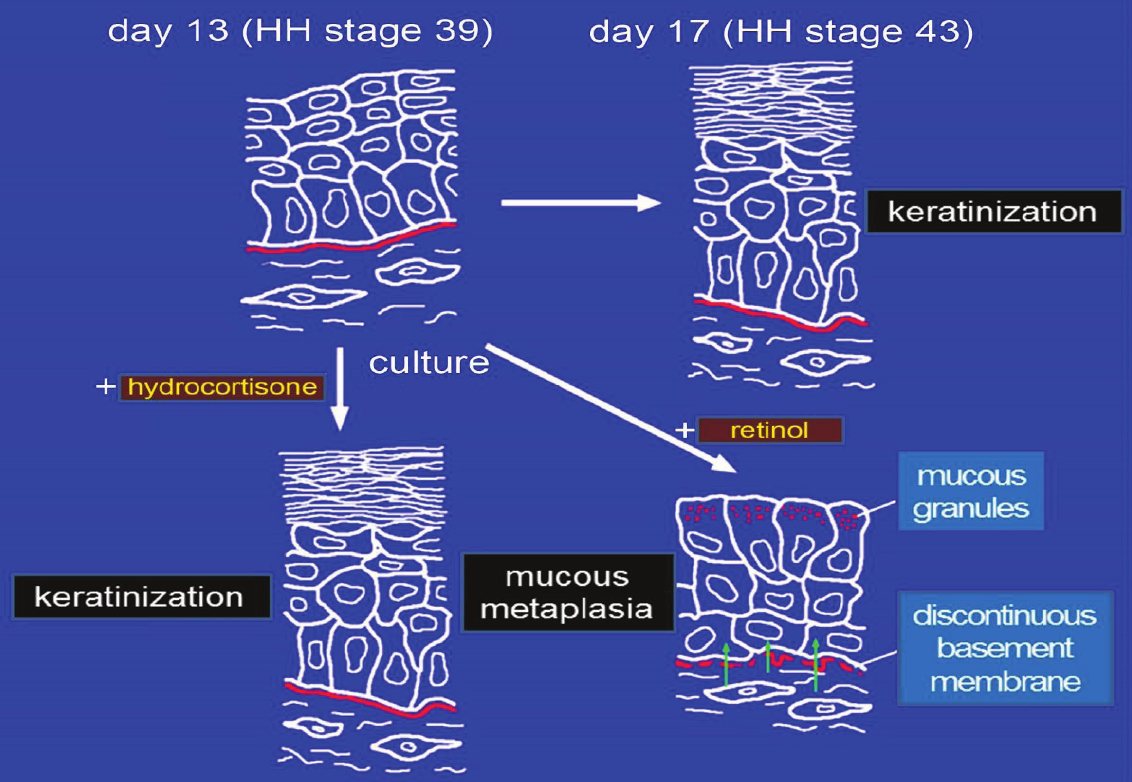
Figure 1. Schematic diagram summarizing the effect of RA on epidermal differentiation of tarsometatarsal chick embryonic skin. Excess retinol can induce epidermal mucous metaplasia (transdifferentiation) in cultured skin obtained from chick embryos [11]. Epidermal mucous metaplasia of 13-day-old chick embryonic tarsometatarsal skin (HH stage 39) can be induced by culturing the skin with excess retinol for only 8 h and then without retinol for six days [34], after which the mucous granules and a discontinuous basement membrane are